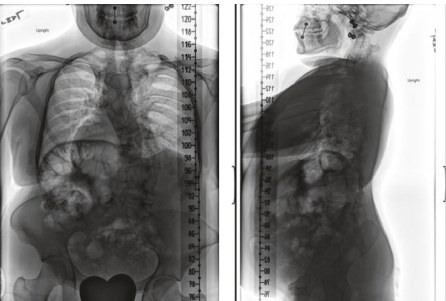
Figure 5: PA and lateral chest radiograph illustrating the asym- metric rib deformities including posteriorly fused and malformed